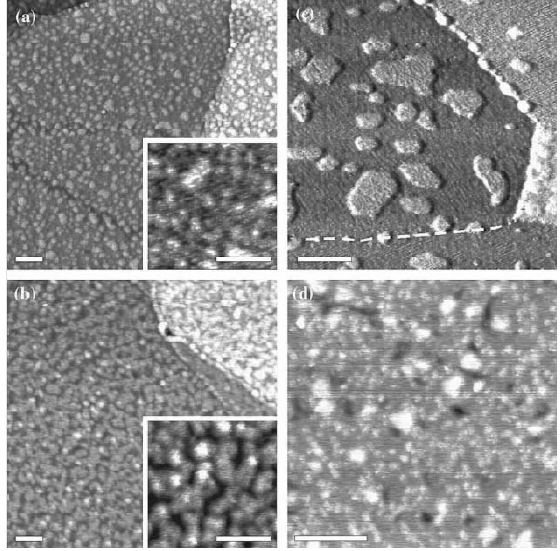
Fig. 19 – STM images of Co deposited at 300 K on thin niobia films. The Co coverage is 0.5Å (a and c) and 2Å (b and d). Images (c) and (d) are taken after heating the same samples to 500 K. The scale bar correspondsto20nm. Tunnelingparametersare: (a)bias1.2V,current 1 nA; (b) 0.75 V, 0.7 nA; (c) 1.25 V, 1.3 nA; (d) 0.75 V, 1 nA. Image (c) is presented in differentiated contrast, where the domain boundary is marked by the dash line (Mendes et al.